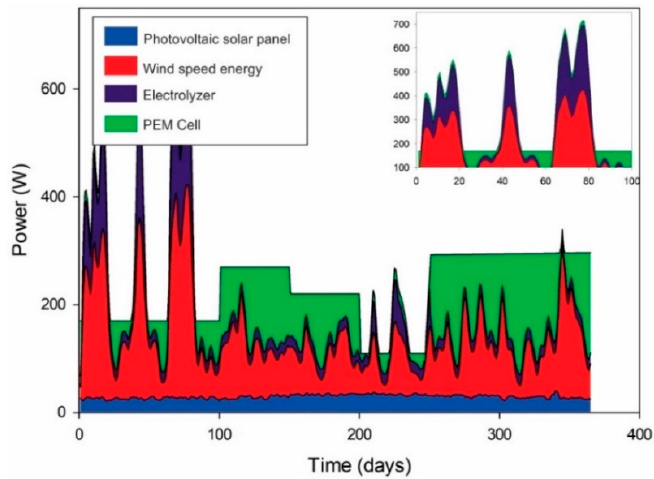
Figure 13. Power in Bremen (Germany).